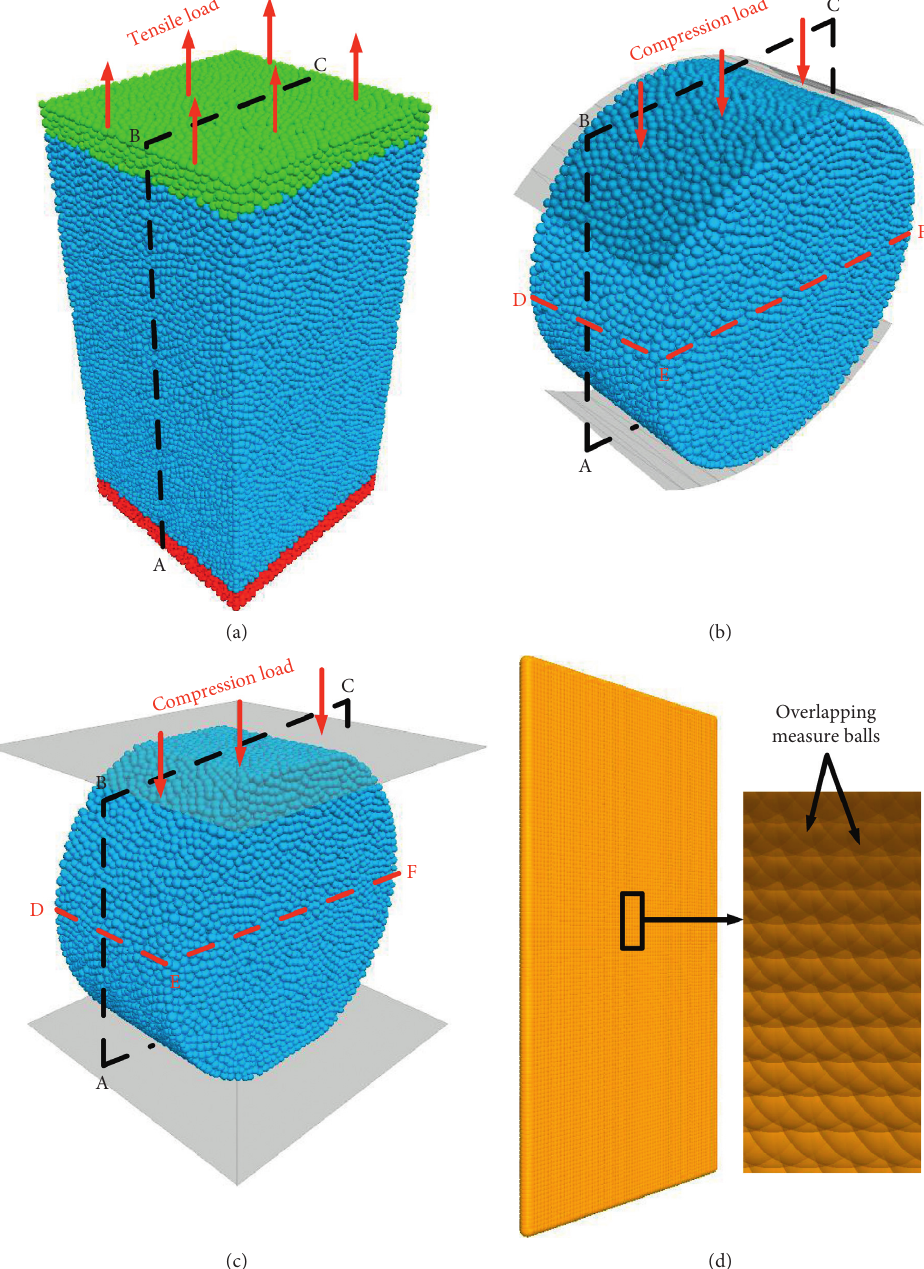
Figure 9: Numerical simulations: (a–c) DT, BT, and FBT models, respectively; (d) stress monitor plane, composing of measure